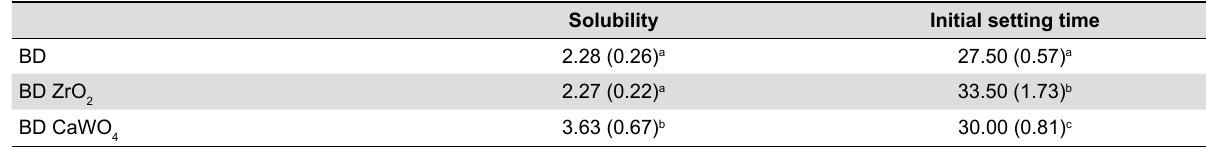
Table 3- Mean and standard deviation of solubility (% of mass lost) and initial setting time (in minutes) of the materials